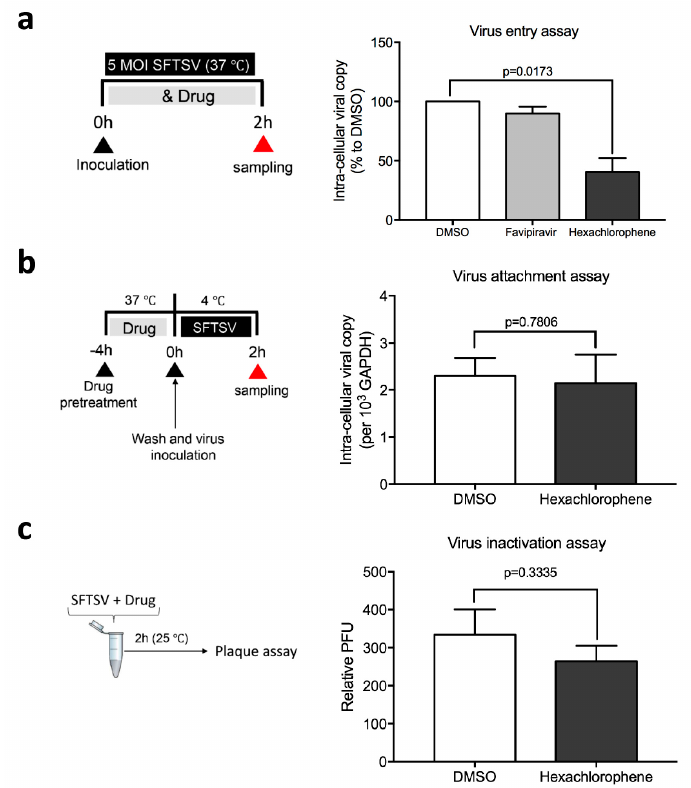
Figure 4. Hexachlorophene interferes with SFTSV entry without inhibiting viral attachment to host cells or inactivating the virions. ( a ) SFTSV entry assay. Vero cells were infected with the mixture of SFTSV (MOI = 5.0) and indicated drug for 2 h, followed by intensive wash and detection of intracellular SFTSV viral RNA load by qRT-PCR assays. Favipiravir (T-705), a known virus polymerase inhibitor, was used as the negative control. ( b ) SFTSV attachment assay. Vero cells were pre-treated by hexachlorophene for 4 h, followed by intensive wash and shift to 4 ◦ C incubate with SFTSV (MOI = 5.0). After 2 h, the infectious inoculum was removed, cells were washed, and the intra-cellular viral RNA load was determined by qRT-PCR. ( c ) SFTSV inactivation assay. SFTSV was incubated with 10 µ M hexachlorophene for 2 h, followed by standard plaque assay from diluting the mixture for 1000 fold (i.e., the remaining concentration of hexachlorophene was below its IC 50 ). All experiments were performed in triplicates. Data are presented as mean values ± standard deviations. P value